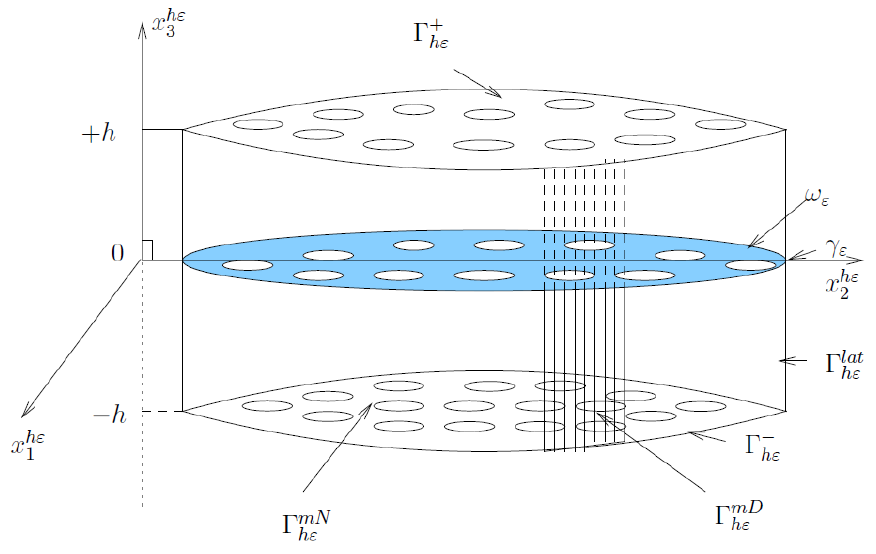
Figure 1. Perforated piezoelectric